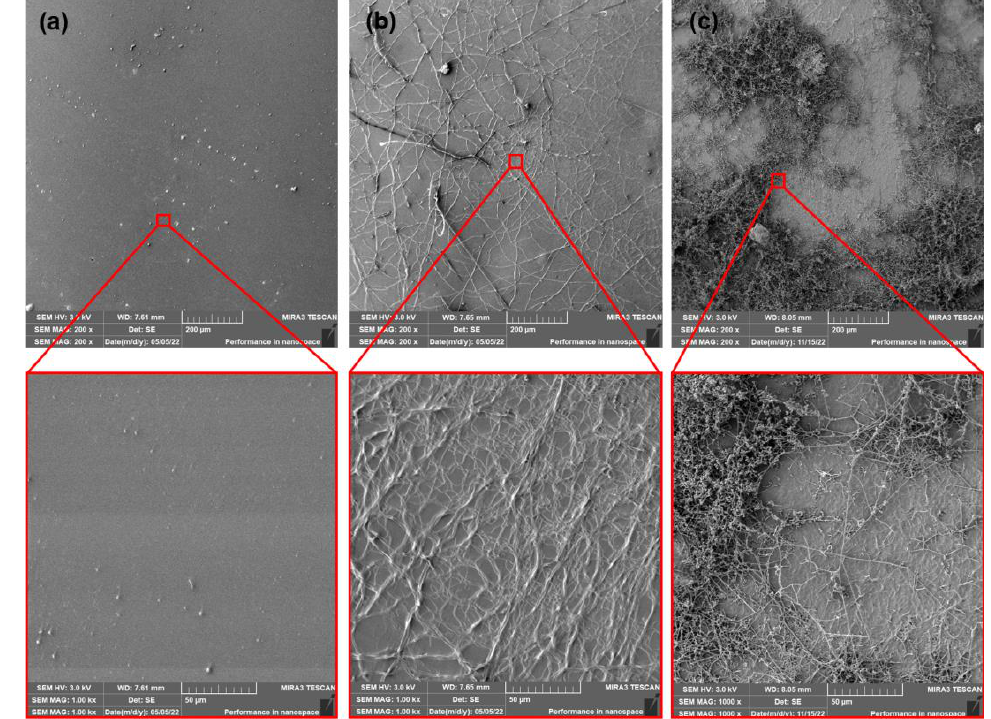
Figure 15. SEM images of aged PLA/MC2192 films ( a ) at initial state and after ( b ) 14 days of thermophilic composting, and ( c ) 28 days of thermophilic composting.